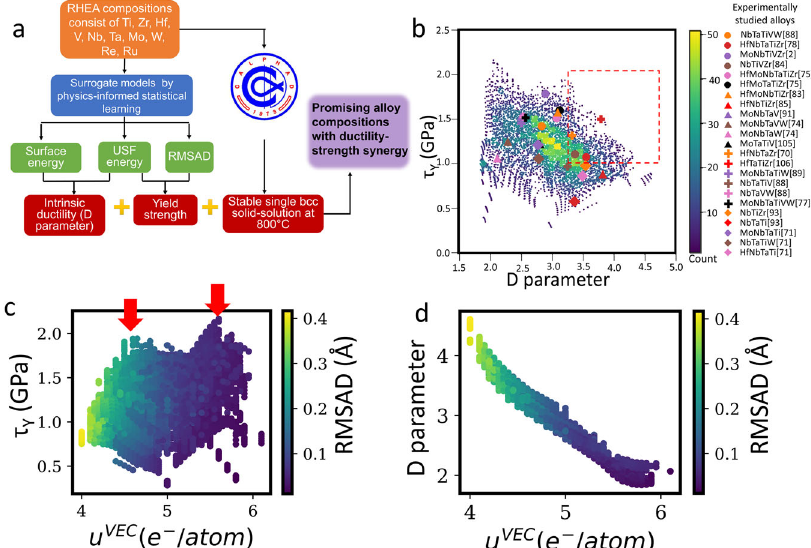
Fig. 8 A high-throughput framework for screening of RHEAs with a good combination of ductility and strength. a A fl owchart detailing the screening process of the framework. The RMSAD and yield strength are predicted, using the surrogate models developed in the present work, while intrinsic ductility is predicted from the models in our previous work 56 . The phase stability assessment is performed using the TCHEA4 database implemented in the Thermo-Calc Software 99 . b A scatter histogram of the yield strength ( τ Y ) and intrinsic ductility (D parameter) of the screened alloys that are single-phase solid solution at 800 °C. The data points that overlap with more other points within a bin area are coded by a warmer color. Experimentally studied RHEAs are also identi fi ed to show where the current experimental literature on equimolar compositions exists and where there is potential to optimize properties by exploring non-equimolar compositions. The red-dashed box illuminates a range of previously unexplored chemical compositions promising for achieving a single-phase RHEAs with a combination of high strength ( τ Y > 1 GPa) and reasonable ductility (D parameter > 3.3). Scatterplots showing effect of VEC on ( c ) yield strength and ( d ) the D parameter of single-phase RHEAs. In ( c ) and ( d ), RMSAD is color mapped onto points to show how VEC and RMSAD can be optimized in tandem for high-performance alloy